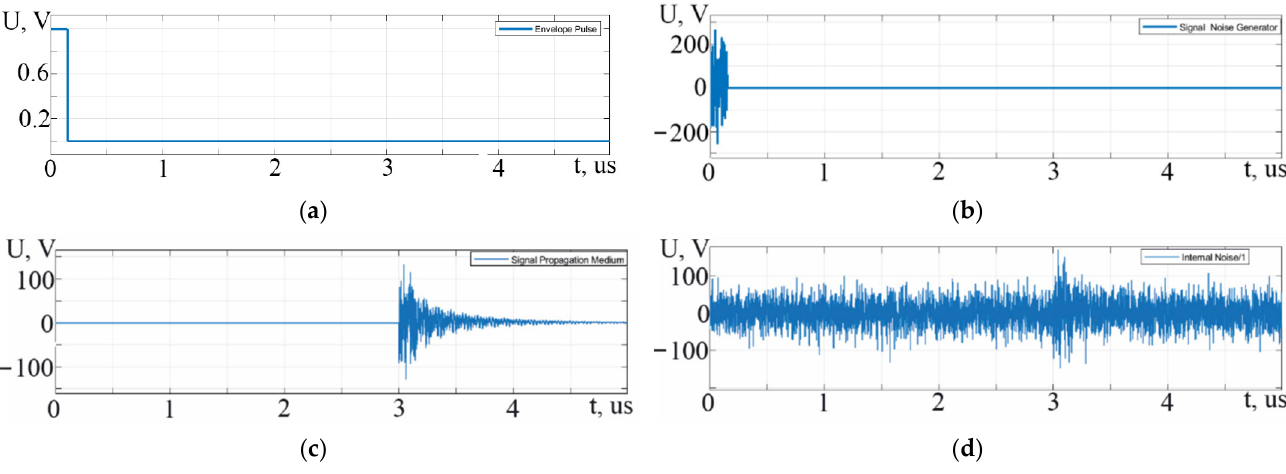
Figure 3. Signals at the blocks output: ( a ) pulse envelop; ( b ) signal noise generator; ( c ) signal propagation medium; and ( d ) internal noise.